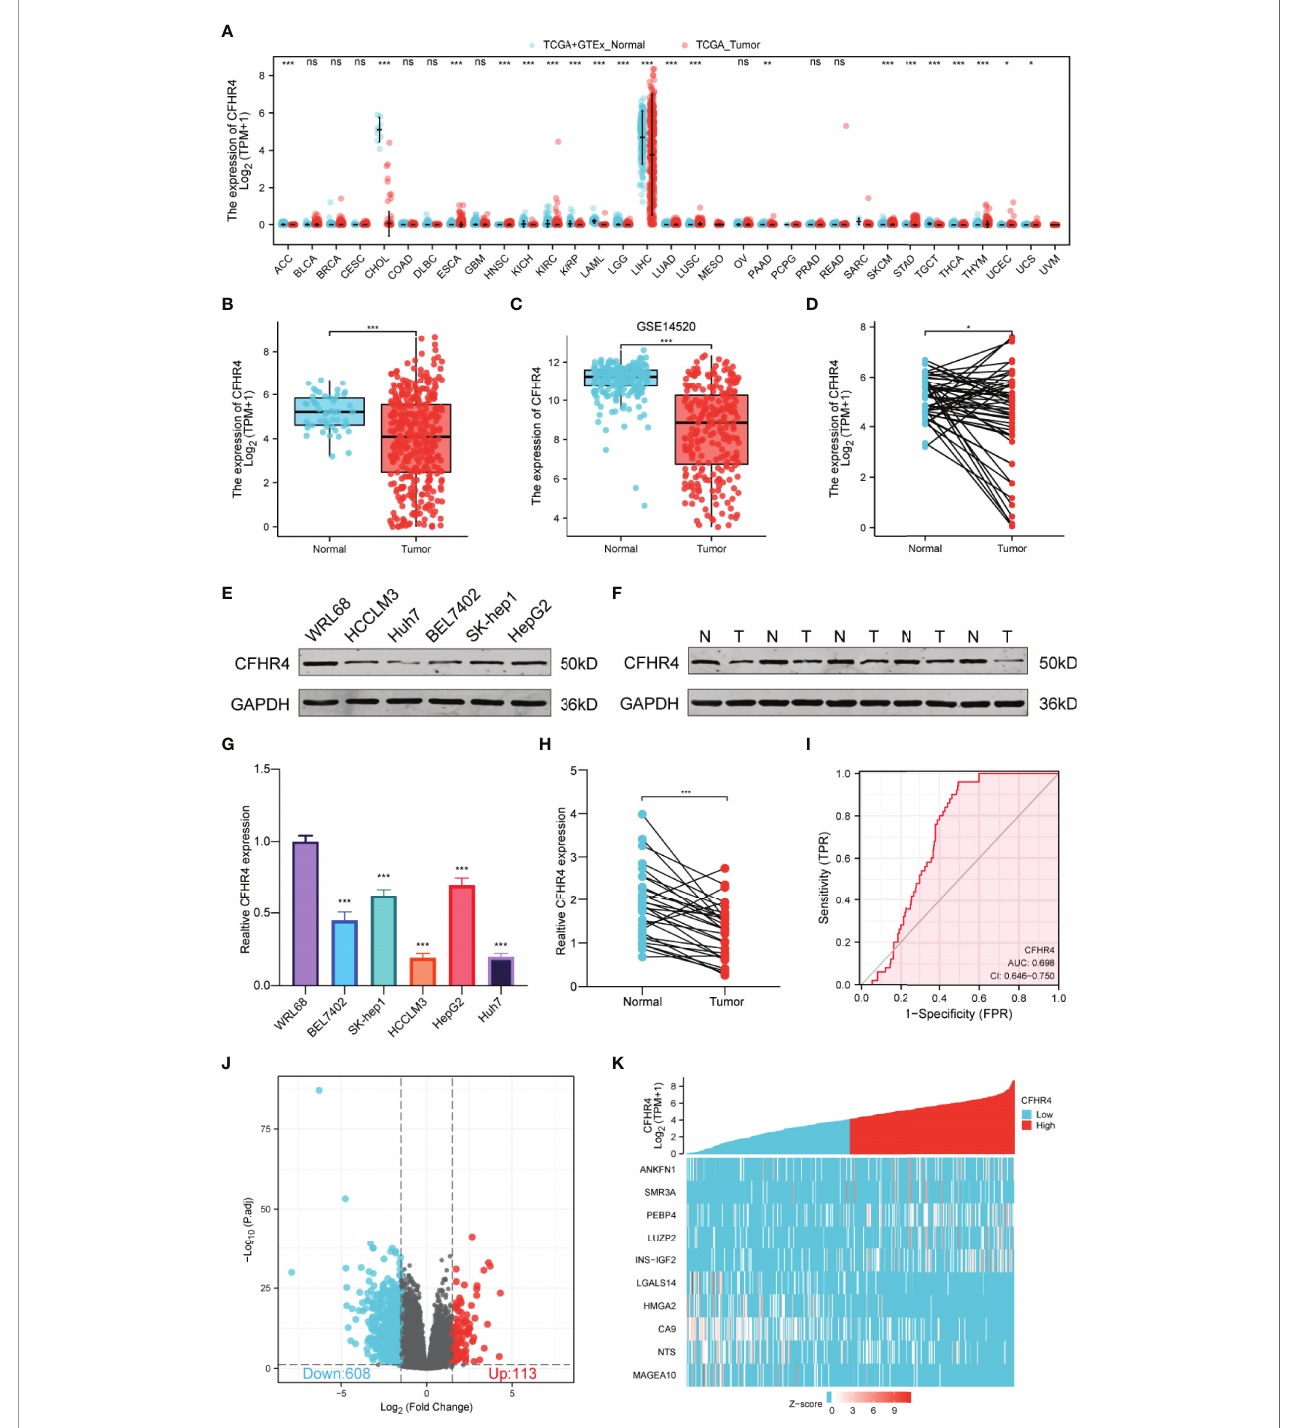
FIGURE 1 | Differences in the expression of CFHR4 and CFHR4-associated DEGs. (A) CFHR4 expression levels in different cancer tissues compared to normal tissues (TCGA). (B – D) CFHR4 expression in HCC samples. (E) CFHR4 expression was detected in WRL68, BEL7402, SK-Hep1, HCCLM3, HepG2, and Huh7 cell lines using Western blotting. (F) CFHR4 protein expression in 30 paired adjacent noncancerous tissues and HCC tissues. (G) CFHR4 expression was detected in WRL68, BEL7402, SK-Hep1, HCCLM3, HepG2, and Huh7 cell lines using PCR. (H) CFHR4 mRNA expression in 30 paired adjacent noncancerous tissues and HCC tissues. (I) ROC curves were created to investigate the value of CFHR4 in identifying HCC tissues. (J, K) Volcano plots of the DEGs and heatmap showing the top 10 DEGs. *p < 0.05, **p < 0.01, ***p < 0.001, NS, no signi fi